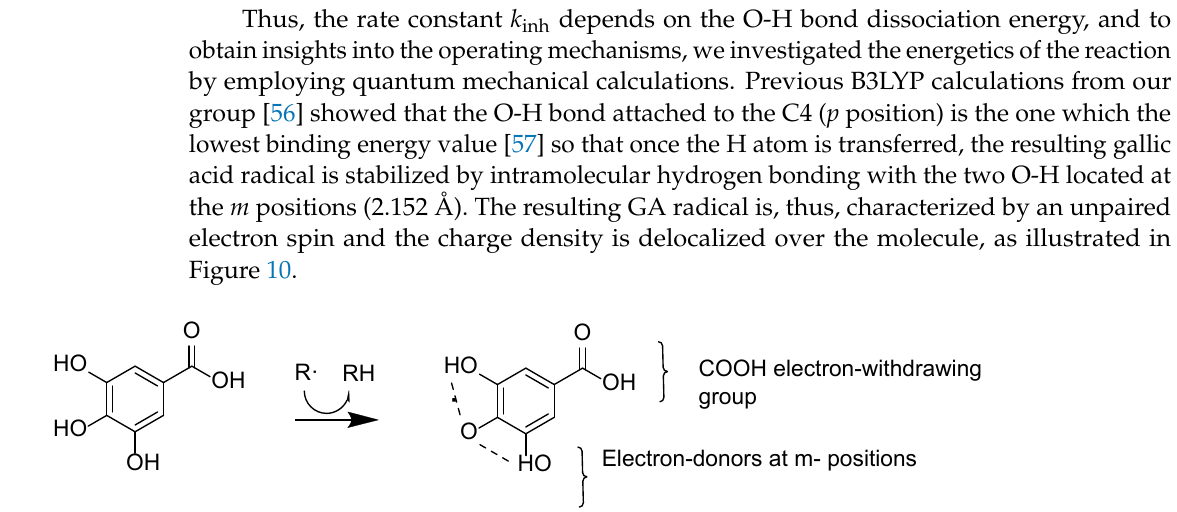
16 of 21 Figure 9. Oxidation kinetic profiles of conjugate dienes (CD) content (g/L) in 1:9 ( v:v ) olive-oil-in- water nanoemulsions, T = 60 °C in absence ( • control) and presence of gallic acid-( • GA) ([GA T ] = 10 − 4 M). Efficient antioxidants are those whose rate of inhibition (Reaction 5 in Scheme 2) is higher than the rate of propagation (Reaction 3 in Scheme 2) [15,16,45]. According to the theory of absolute rates, the rate of a reaction is closely related to the energy barriers involved in their transition states [26,27], and we deemed it important to investigate the energetics of both the inhibited and non-inhibited reactions theoretically. The rate of the inhibition reaction, Reaction 5 in Scheme 2, depends on both the effective concentrations of the antioxidant in the interfacial region and on the rate constant of the reaction, k inh [15,45]. The effective concentration in the interfacial region was